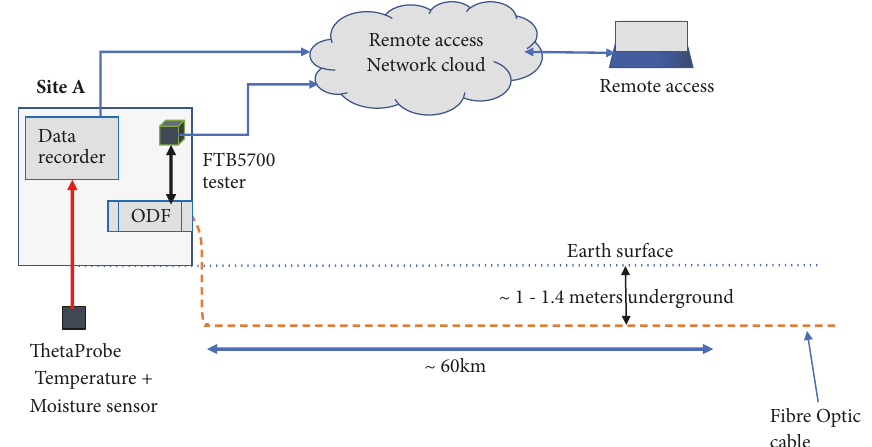
Figure 2: Setup of the field tests that were conducted using a single ended tester, moisture, and temperature sensor.